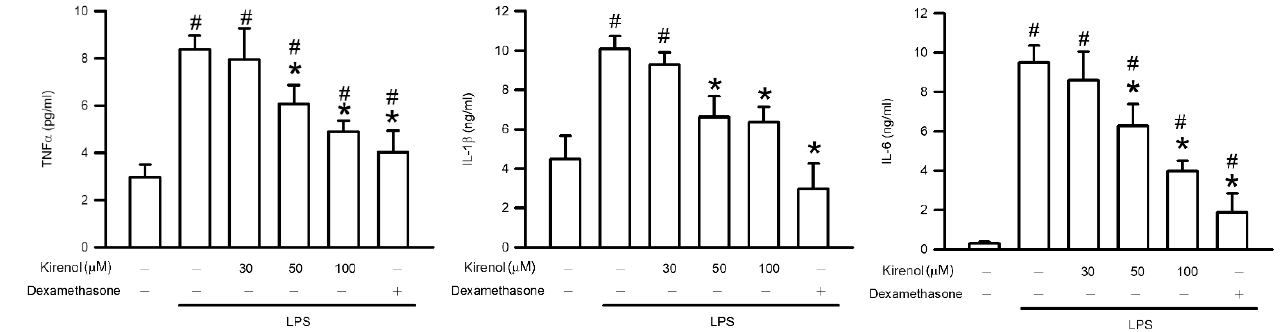
Figure 5. Kirenol protected against LPS-induced generation of proinflammatory cytokines in BALF. Proinflammatory cytokines, including TNF α , IL-1 β , and IL-6, were determined by the ELISA assay. Values are shown the mean ± S.D. of 3–4 mice per group. # represents the significant difference compared with the Group I ( p < 0.05); * represents the significant difference compared with the Group II ( p < 0.05).